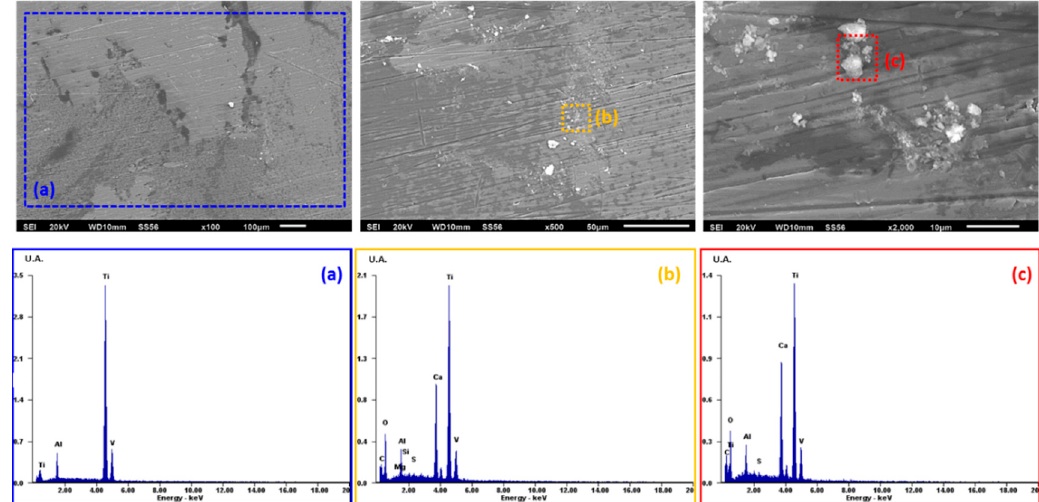
Figure 5. SEM surface morphology micrographs and EDS spectrum of Ti6Al4V in Fusobacterium nucleatum + Streptococcus gordonii: ( a ) 100X, ( b ) 500X, and ( c ) 2000X.